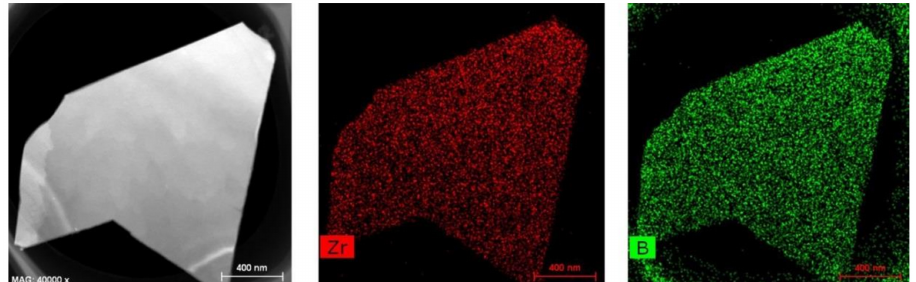
Figure 5. TEM and EDS mapping images of the as-prepared ZrB 2 -SiC composite powders fired at 1250 ◦ C for 20